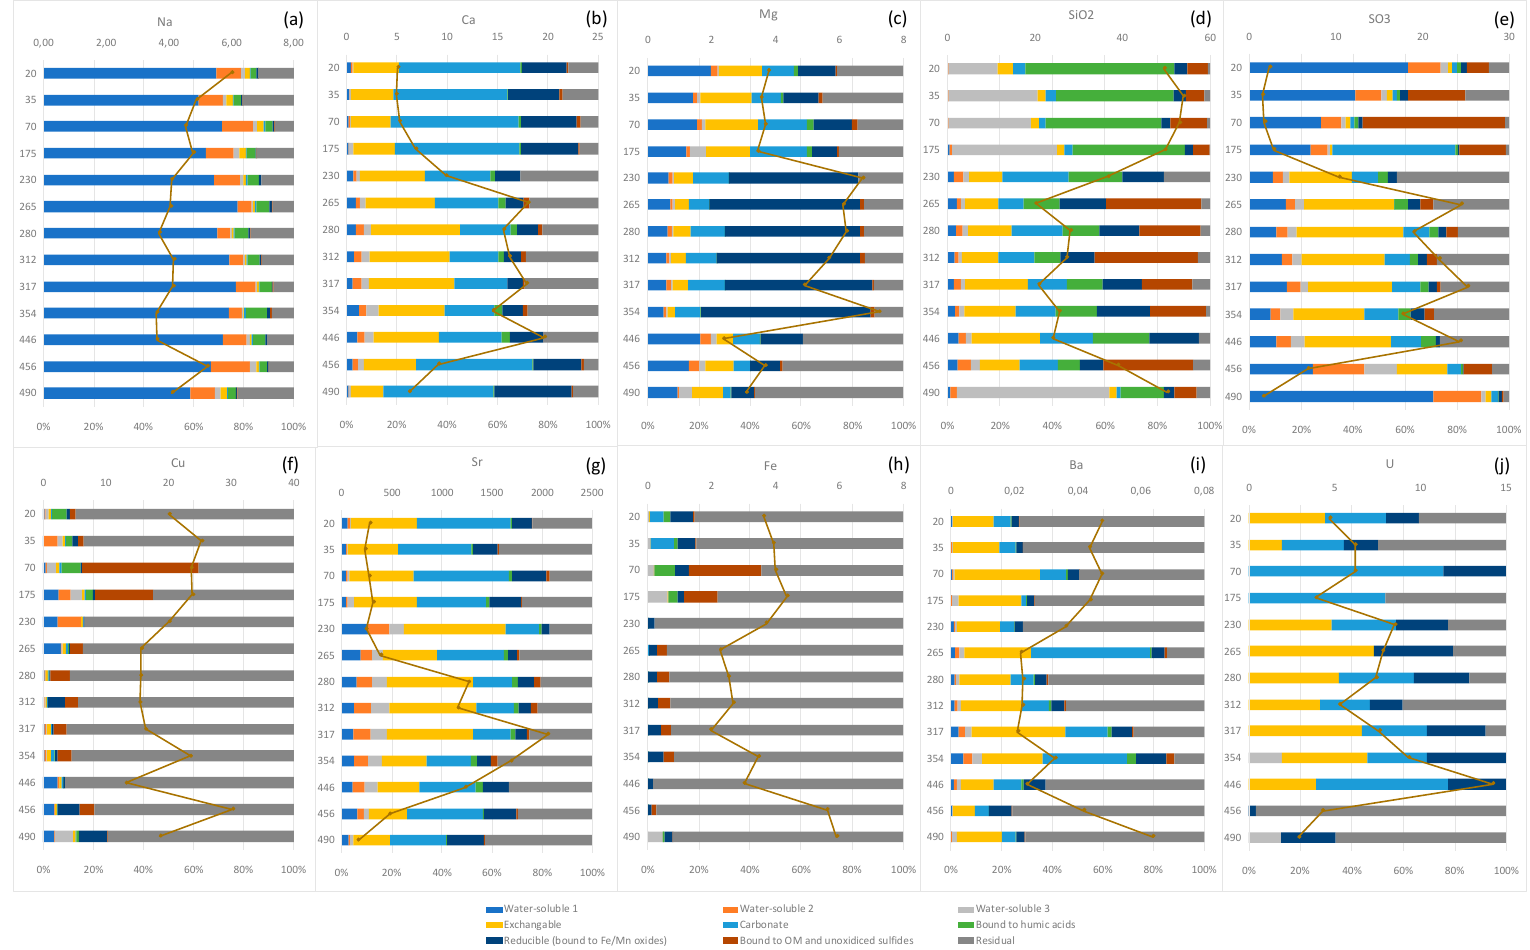
Figure 8. Vertical profiles (cm) of elements (in %) extracted in the sequential extraction. The line represents element concentration is in mg / kg units (Na–( a ), Ca–( b ), Mg–( c ), SiO 2 –( d ), SO 3 –( e ), Cu–( f ), Sr–( g ), Fe–( h ), Ba–( i ), U–( j ).